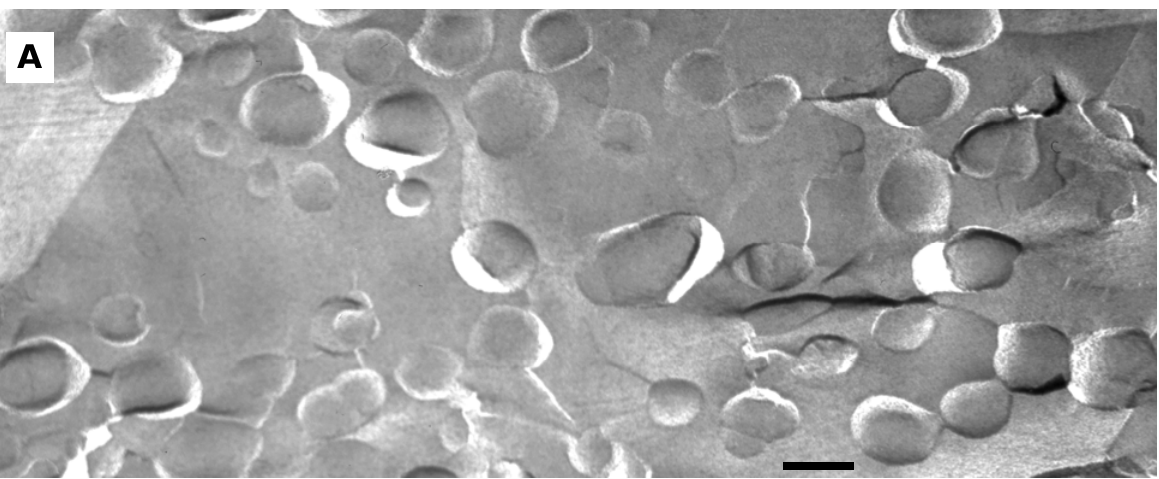
Figure 6. Freeze-fracture electron microscopy of the 1 /POPC/PEG-ceramide fliposome formulation at pH 7.4 ( A ) and 5 minutes after adjusting the pH to 5.5 with diluted acetic acid ( B , C ). Examples of division, buds, and stripes are shown with white, black, and yellow arrows respectively. The bars represent 100